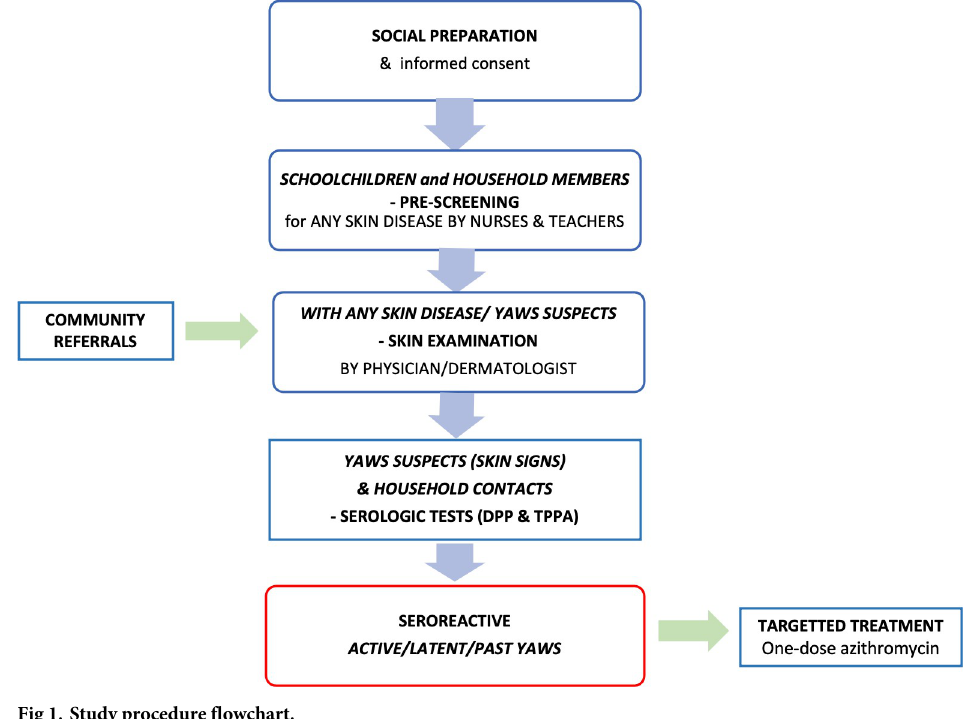
Fig 1. Study procedure